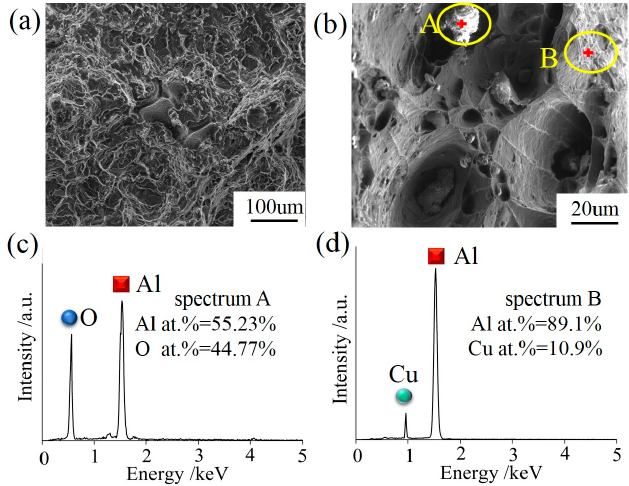
Figure 7. ( a ) The gray-layered microstructure in SEM morphology of CHTI; ( b – d ) EDS microanalysis spectra from defects and matrix, respectively.